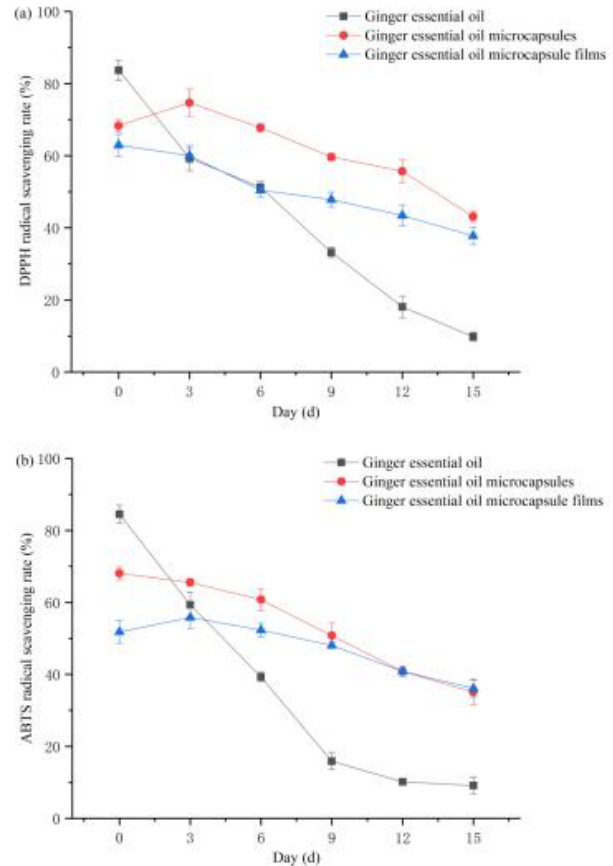
Figure 4. Analysis of antioxidant properties: ( a ) DPPH radical scavenging rate; ( b ) ABTS radical scavenging rate.